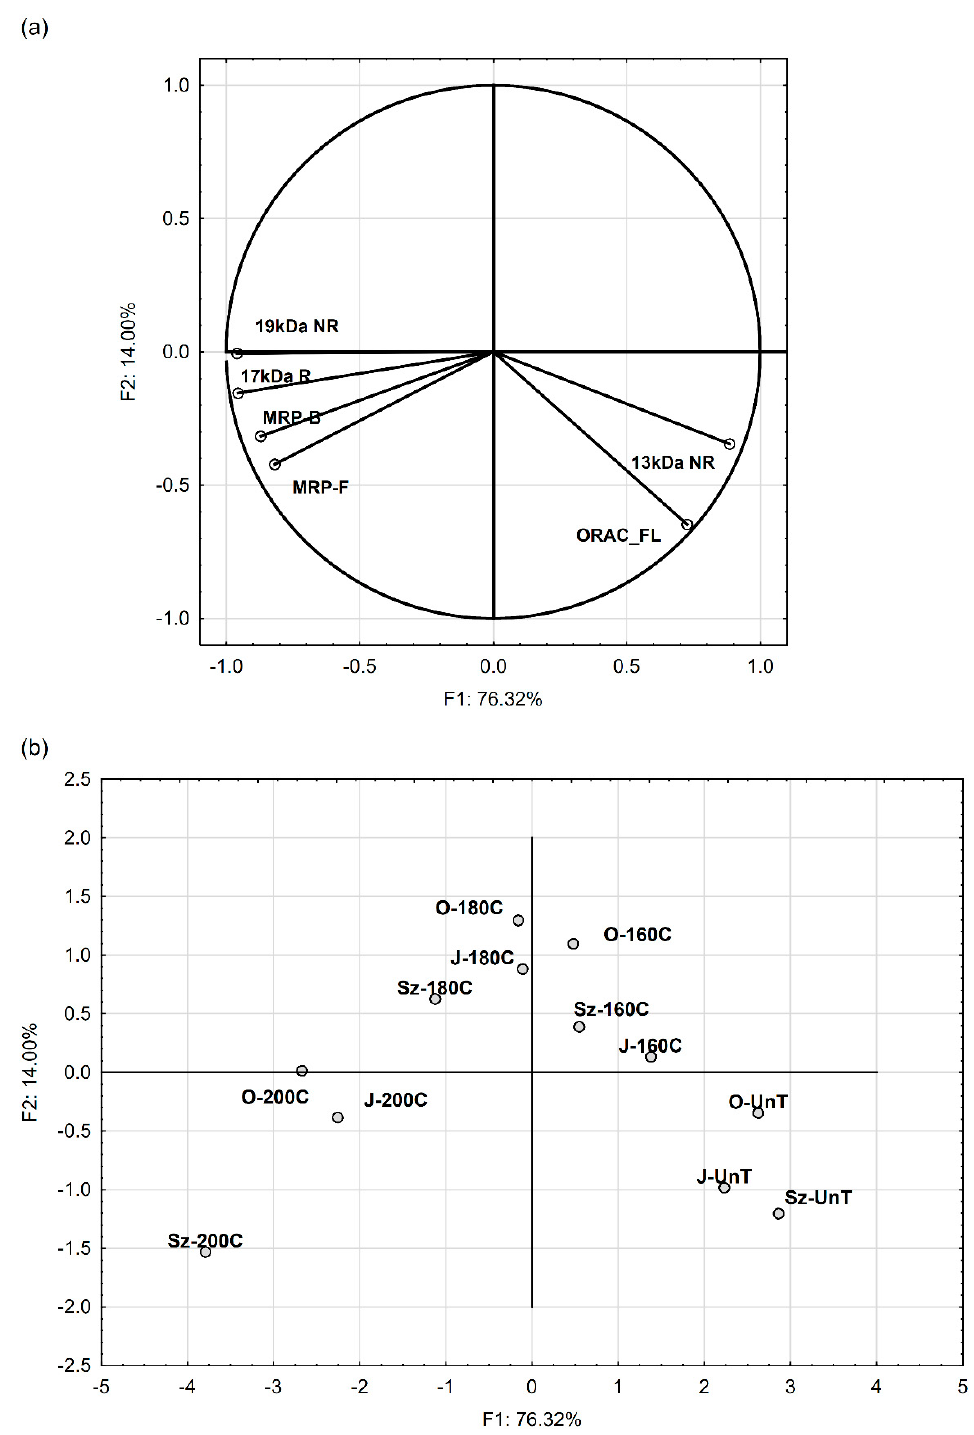
Figure 3. Plots of the first two principal components (F1 and F2): ( a ) variability-factor coordinates plot, ( b ) case-factor coordinates plot; flaxseed cultivars: Oliwin (O), Jantarol (J), and Szafir (Sz); flaxseed treatment: untreated (UnT) and roasted (8 min. at 160 °C, 180 °C and 200 °C). The factor coordinates of the variables (Figure 3a) indicate that F1 was mostly explained by the changes in the protein share of 19 kDa NR, 17 kDa R ( − 0.96), and 13 kDa NR (0.88), and also by the F-MRP and B-MRP content ( − 0.82 and − 0.87, respectively). On the other hand, factor F2 was